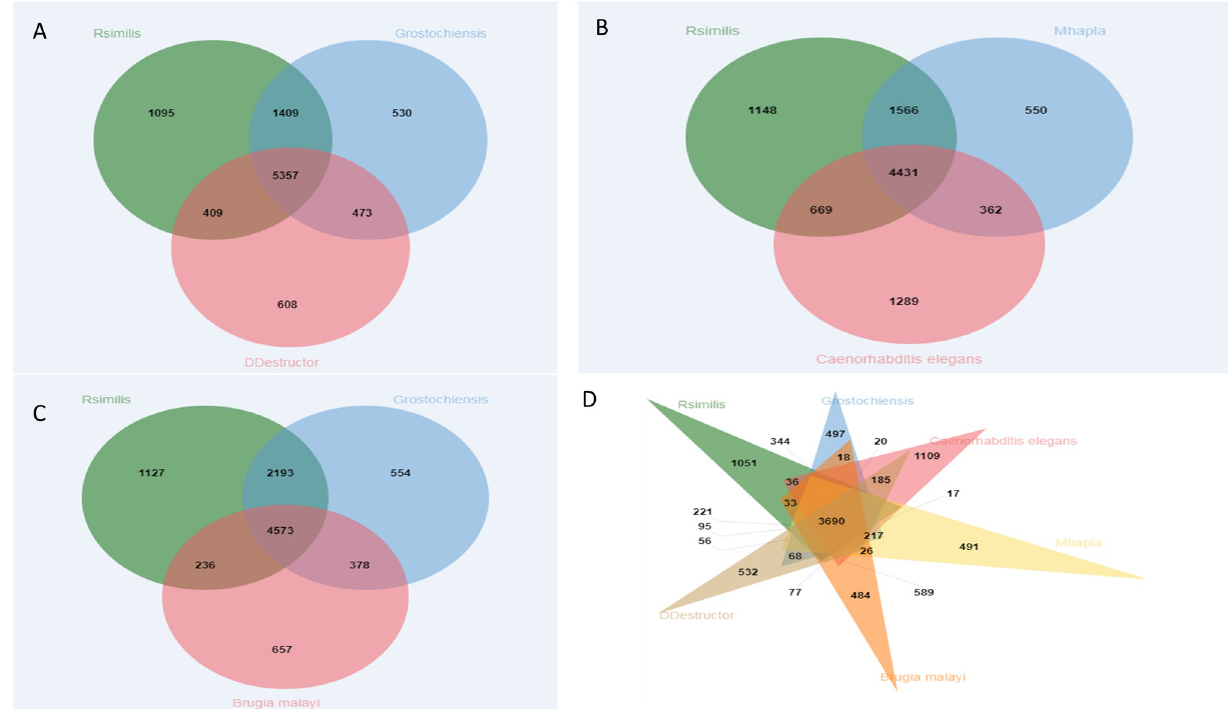
Fig 2. Venn diagrams displaying overlapping ortholog clusters shared by R . similis . ( A ) Orthologous clusters shared between R . similis , the potato cyst nematode G . rostochiensis and the potato rot nematode D . destructor ( B ) Orthologous clusters shared between R . similis , the root-knot nematode M . hapla and the free-living nematode C . elegans ( C ) Orthologous clusters shared between R . similis , the potato cyst nematode G . rostochiensis and the human parasitic filarial nematode B . malayi ( D ) Orthologous clusters shared between R . similis , G . rostochiensis , M . hapla , C . elegans , D . destructor and B . malayi